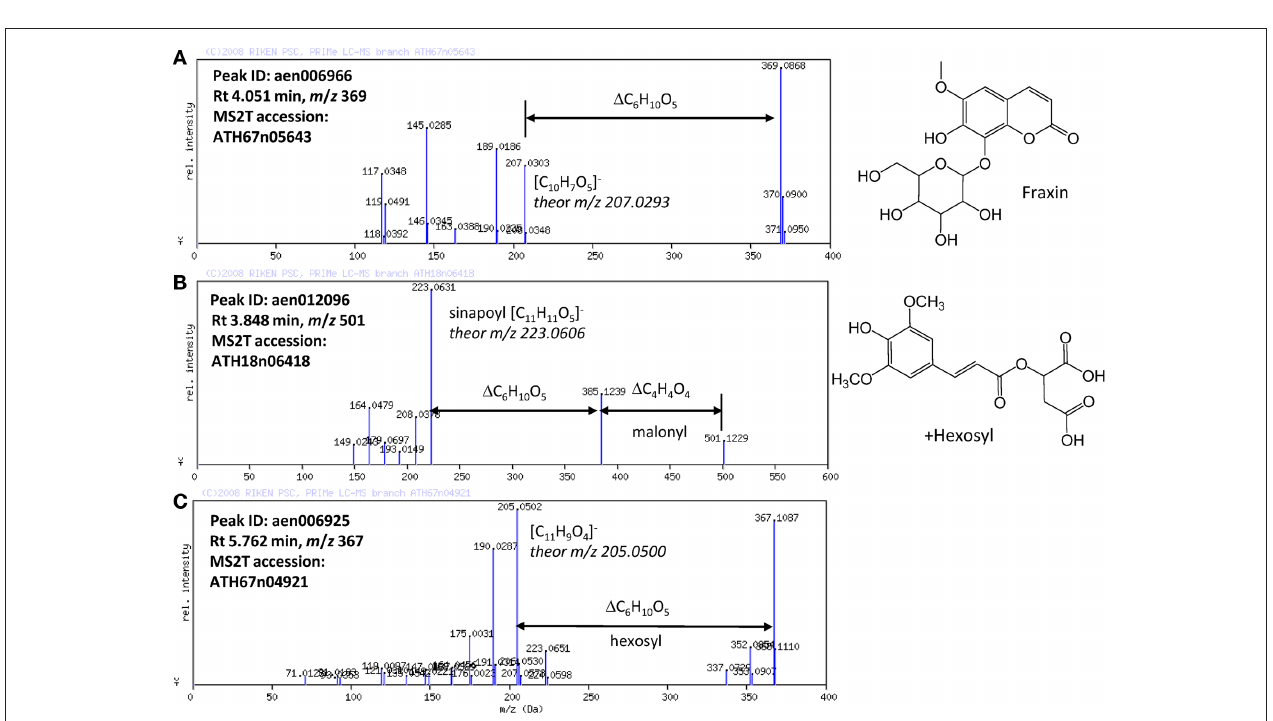
compound ontology information in KNAsSAcK and ReSpect searches were compared to identify a common result. Repeated searching for 19 MS2T accessions resulted in 11 MS2Ts being identified as glucosinolate based on the Class 1 ontology (C) .